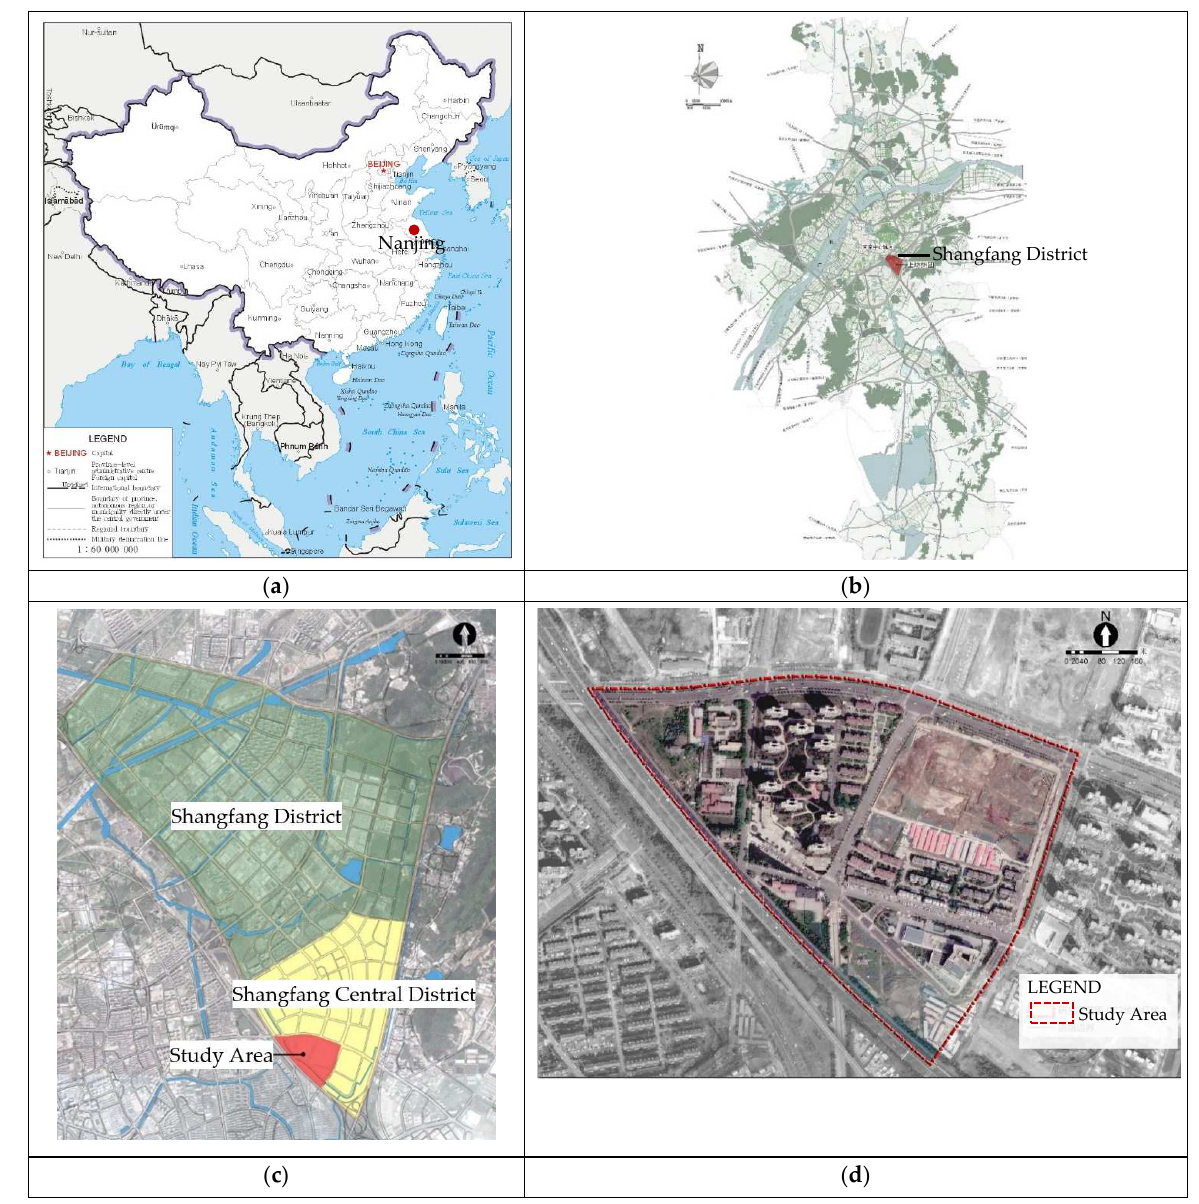
Figure 2. ( a ) Location of Nanjing in China, Source: Ministry of Natural Resources of China; ( b ) Location of Shangfang District in Nanjing; ( c ) Location of the study area in the Shangfang District; ( d ) Satellite image of the study area, Source: Google Maps 2018-10.